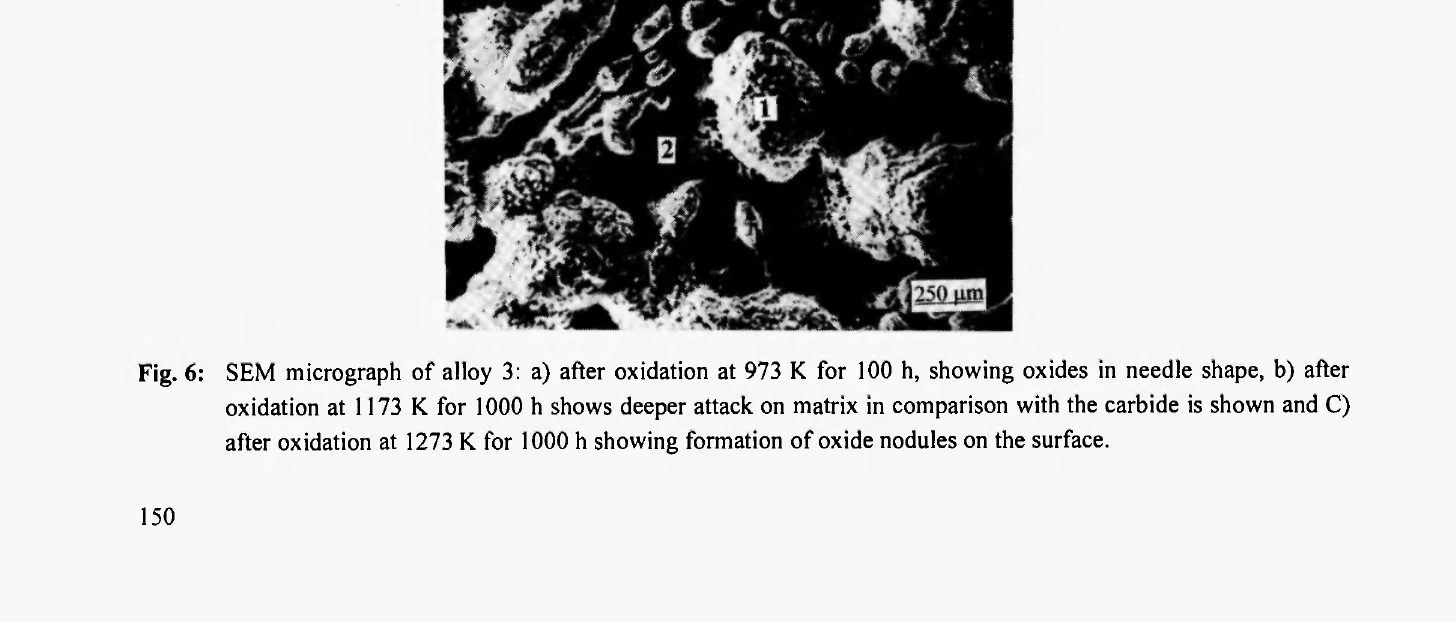
Fig. 4: SEM micrograph of alloy lafter oxidation at 1173 Κ for 1000 h shows formation of grooves between oxides.